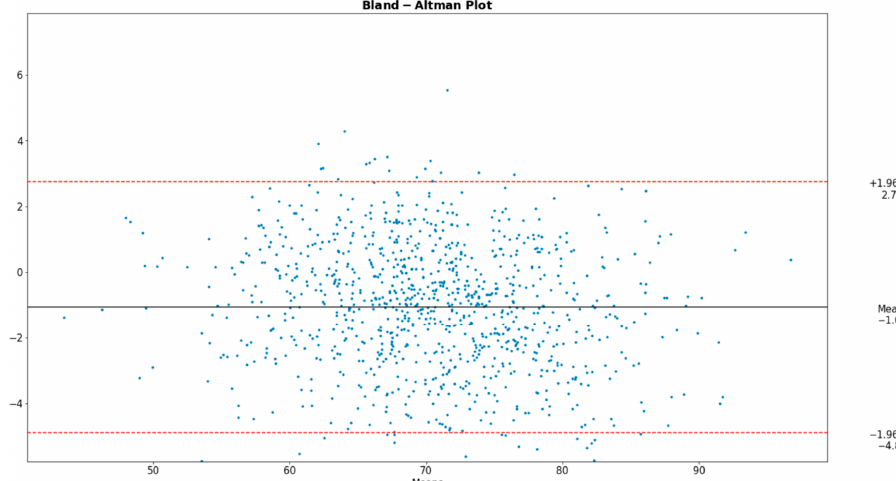
Sensors 2022 , 22 , x FOR PEER REVIEW